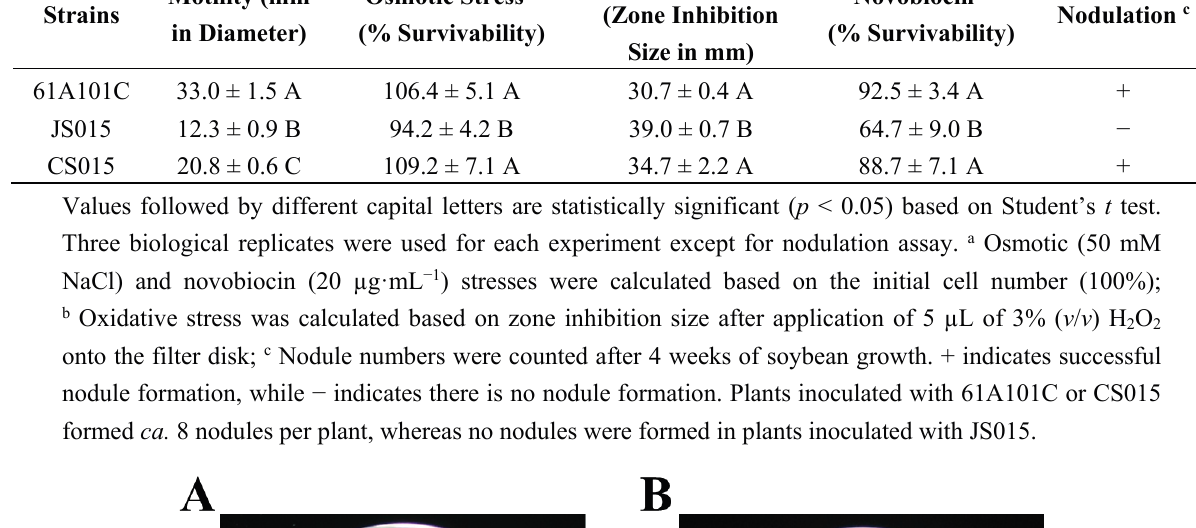
Table 1. Characteristics of three B. japonicum strains in motility, nodulation, and stress responses. Strains